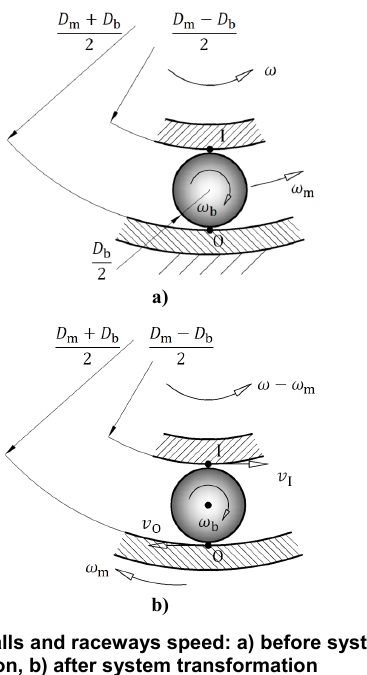
Figure 10. Balls and raceways speed: a) before system transformation, b) after system transformation As the speeds v and v are equal by the I O